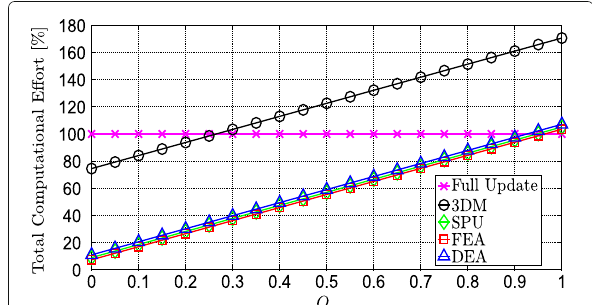
Fig. 14 Total computational effort required per frame for implementing the different tap selection schemes and for updating the MAEC filters using the PUNLMS algorithm as a function of Q . The numbers have been computed for K = 257, R = 5 and L = 20 and have been plotted as a percentage of the effort required for full filter